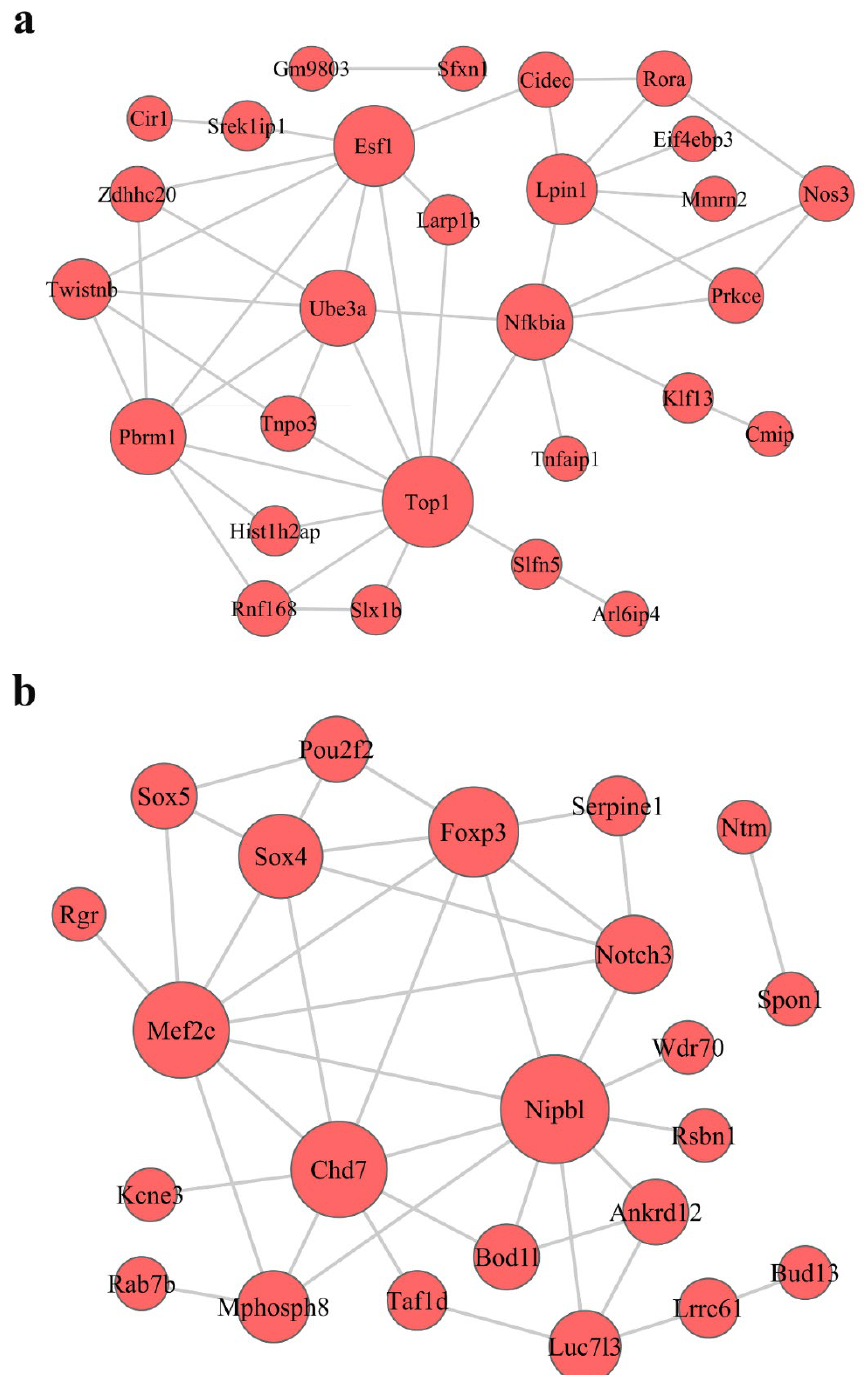
Figure 6. Construction of protein–protein interaction (PPI) networks in the turquoise ( a ) and blue ( b ) modules. Red circles represent mRNA; the size of the circle represents the regulation capacity of mRNA, where larger circles indicate relatively stronger regulation capacity.